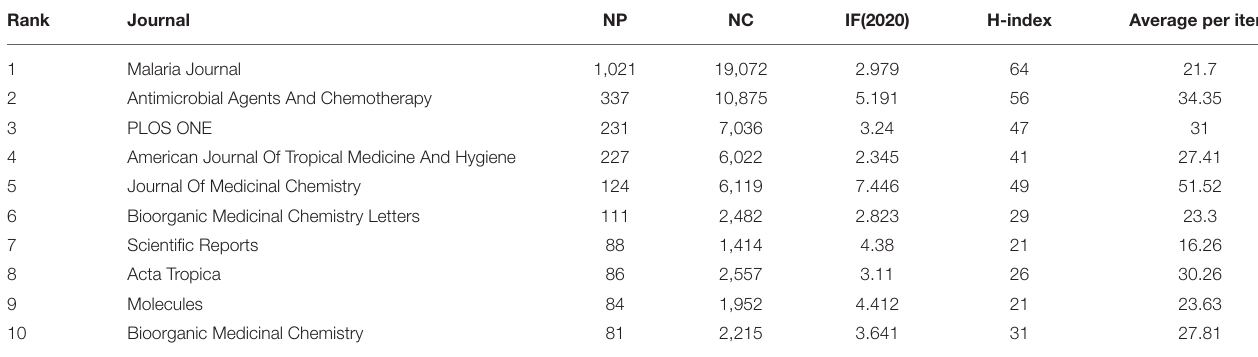
TABLE 4 | The top 10 most active